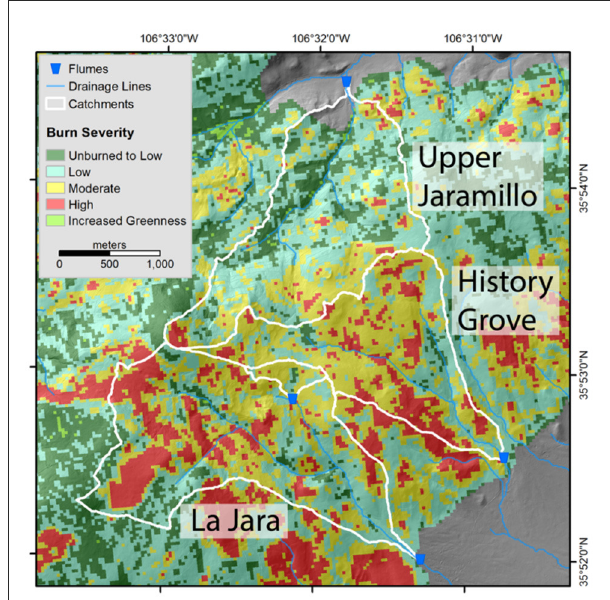
FIGURE2 Fire severity map of the 2013 Thompson Ridge Wildfire—modified from Eidenshink et al. (2007). La Jara catchment has the highest fire impact where 23% of its total area shows a high burn severity (red pixels). Similarly, 21% of History Grove catchment area has been severely impacted by the fire, whereas only 4% of Upper Jaramillo surface area show severe burn conditions. Notice that moderate fire severity (yellow pixels) covers a significant area of the three watersheds − 36%, 53% and 25% of La Jara, History Grove, and Upper Jaramillo,